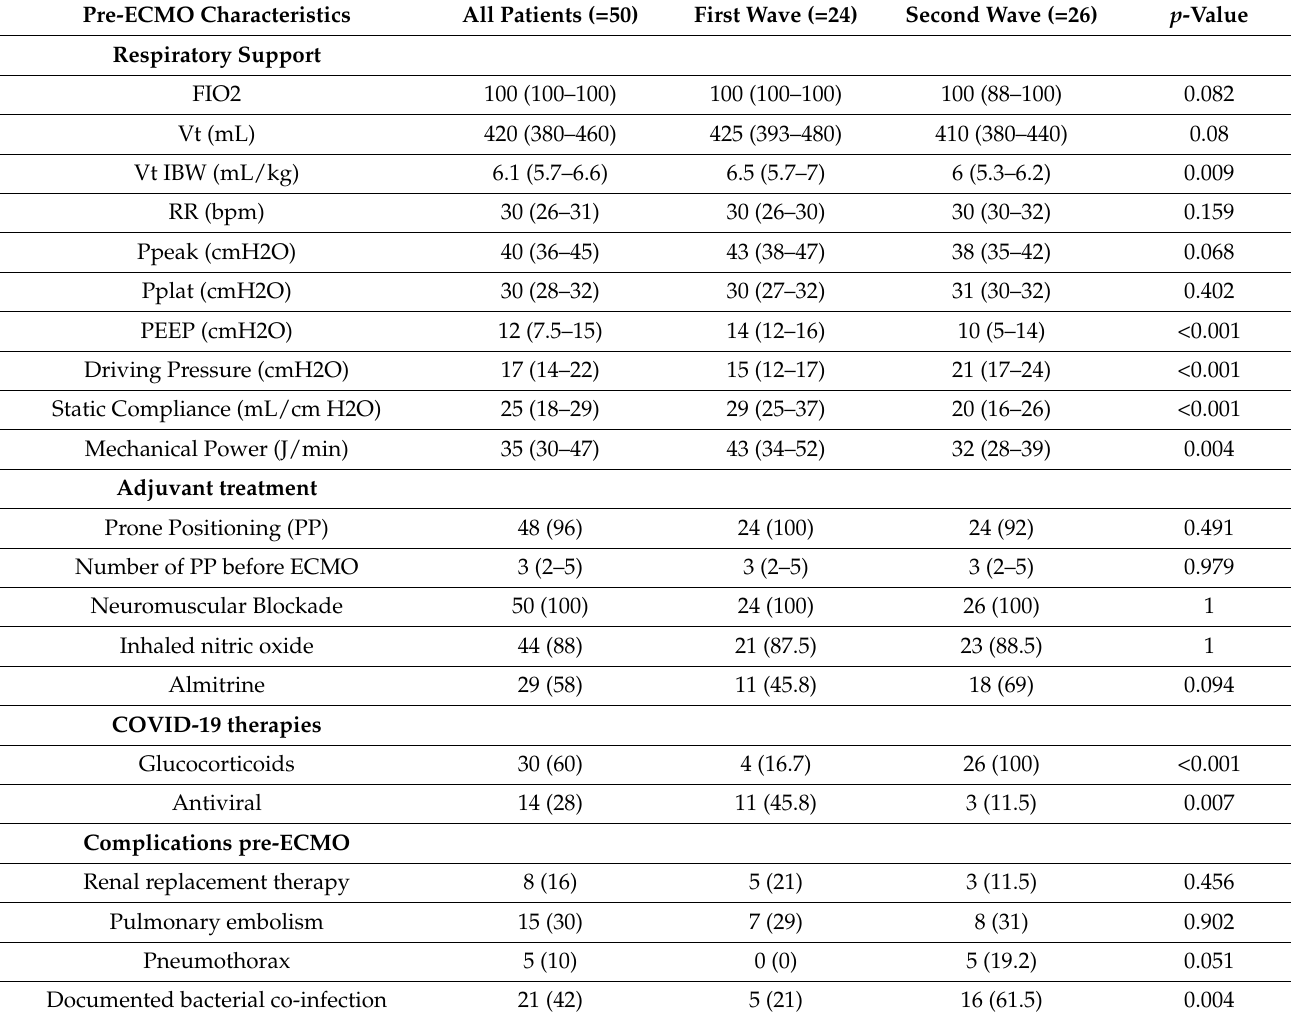
Table 2. Respiratory support, adjuvant treatments, COVID-19 therapies, and complications pre-ECMO in the first and second wave